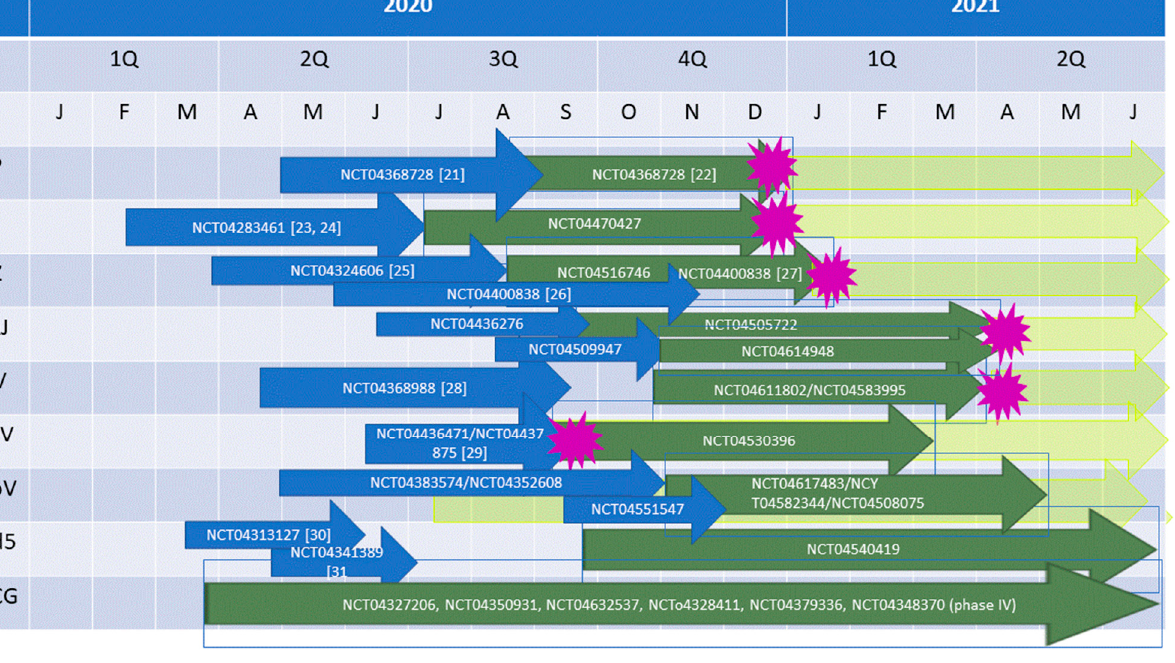
Figure 1. Time line of vaccine production and approval. BP, BioNTech/Pfizer; M, Moderna; AZ, Oxford/Astra Zeneca; J&J, Janssen/Johnson and Johnson; NV, Novavax; SPV, Sputnik V; CoV, CoronaVac; Ad5, Ad5-nCOV; BCG, Mycobacterium bovis. Blue arrows, phase I/II trials; green arrows, phase III trials; yellow arrows, roll out; purple star, (anticipated) approval date. Trial start dates were taken from http://www.clinicaltrials.gov. Approximate end dates of phase I/II trials are the publication dates. End points for unpublished trials a4re guesses by the author. For the last three vaccines, a guess for an approval date was not possible. Note that all start and end dates of trials, as well as approval dates are approximations.